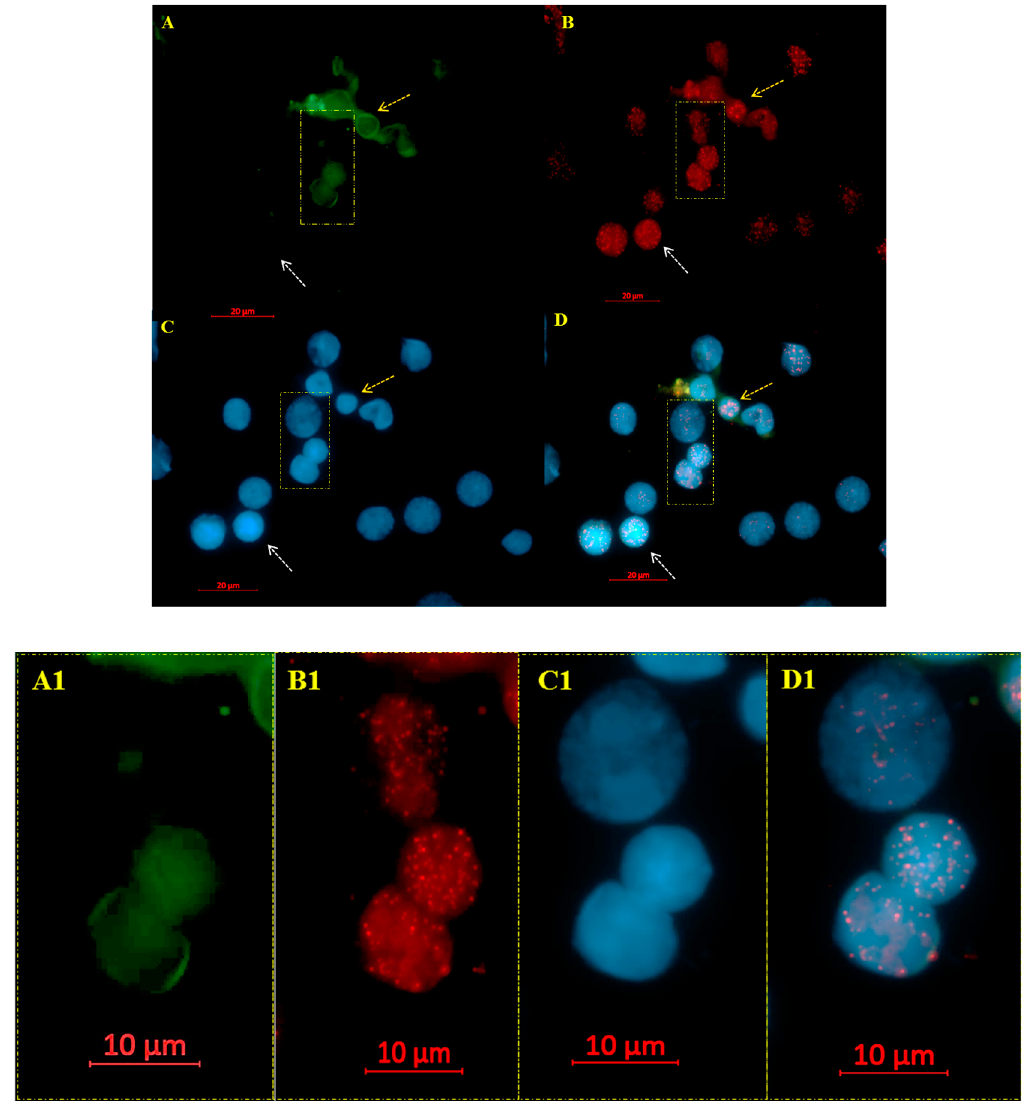
Figure 1. Telomere signals in CD34 + MDS cells ( A – D with magnified view in A1 – D1 ). ( A ) The MDS CD34 positive cells fluoresce green (see arrows in yellow), whereas the other hematopoietic cells remained unstained (see arrows in white). The telomeres, hybridized with Cy3-labeled PNA probes, appear as red signals ( B ). The nuclei are counterstained with DAPI (blue) ( C ). ( D ) Merge of FITC (CD34), Telomeres (CY3) and DAPI.